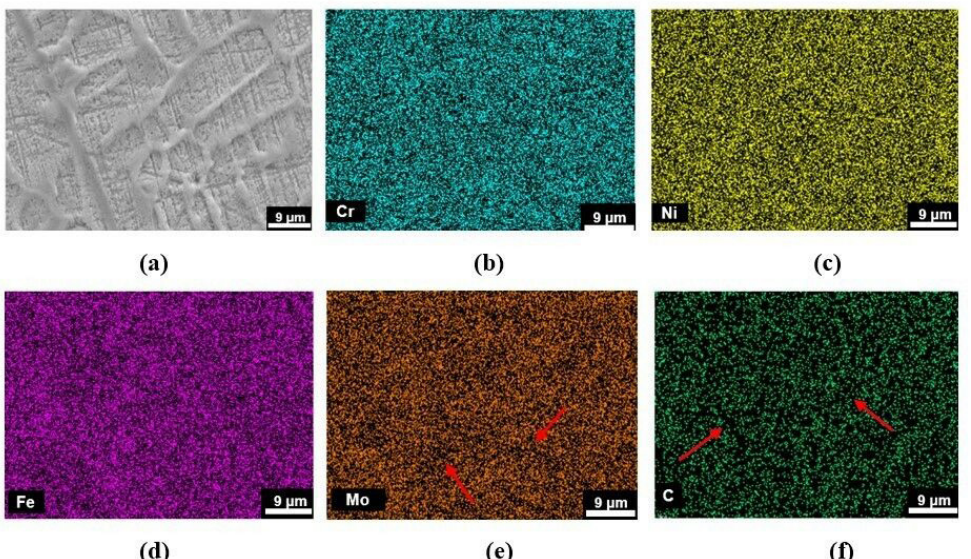
Figure 6. Element mapping by EDS on the 316L stainless steel under the condition of rapid solidification in region RS3. (a) Region RS3; (b) Cr; (c) Ni; (d) Fe; (e) Mo; (f)